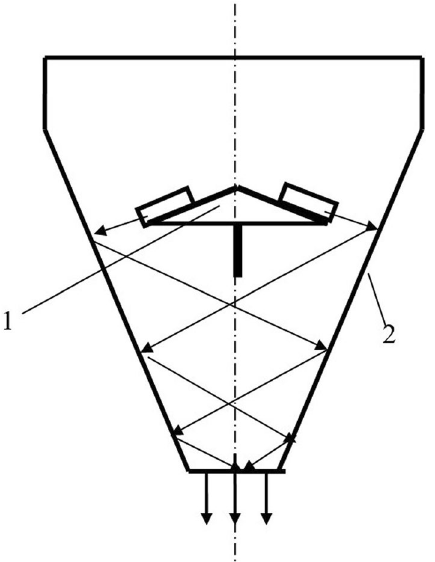
Figure 11. Technological scheme of a centrifugal disk seed treater. Source: author’s